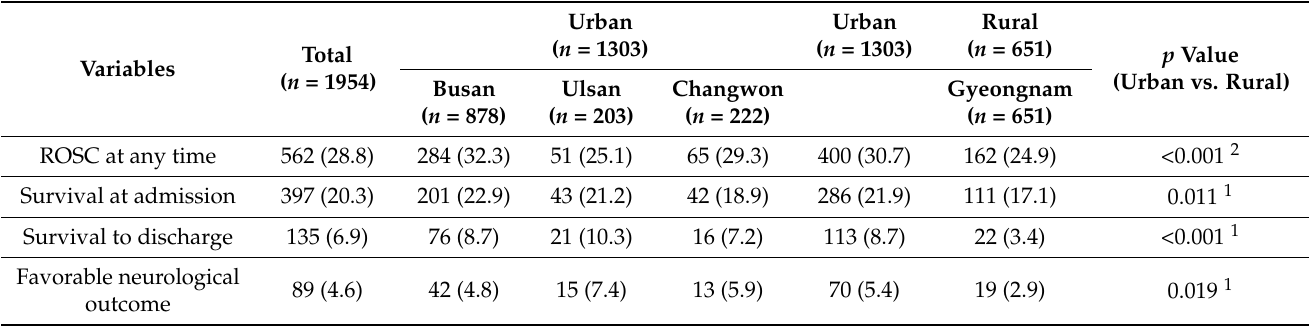
Table 2. Survival outcomes of the study population.